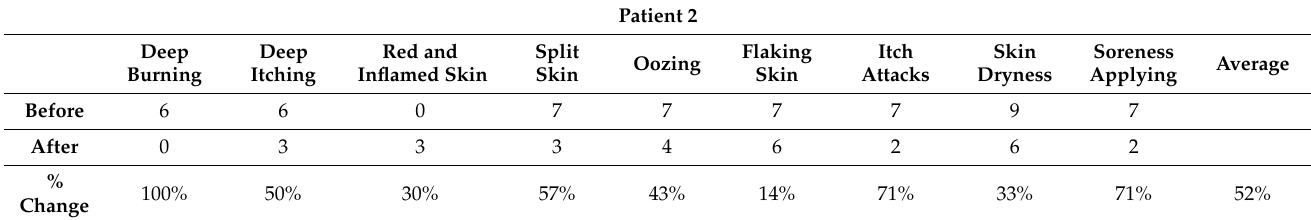
Table 4. Severity scores for Patient 2 before and after completing the study. The numbers in the table are out of ten, with ten being the worst severity, and zero meaning the symptom has ceased to exist. The percentage change in the severity of each symptom is shown in the bottom row.